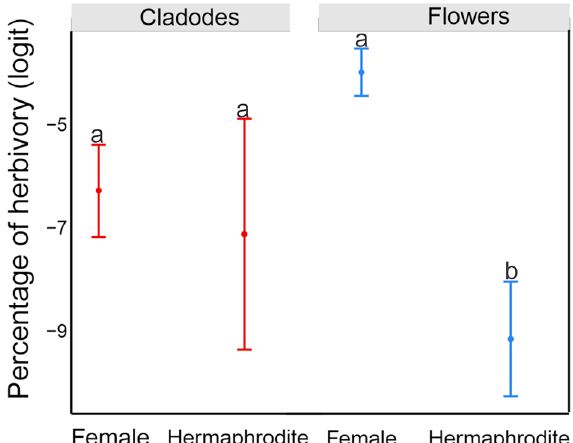
Figure 5. Effects of sexual form and plant structures on cumulative herbivory [proportion]. The figure illustrates the estimated mean values and confidence intervals obtained from a GLM, with Gaussian error distribution and identity link function. Cumulative herbivory was logit-transformed. The explicative variables were sex, type of structure, and their interactions. The difference between the female and hermaphrodite flowers was significant ( P ≤ 0.001). Different letters denote significant differences between the mean values at P ≤